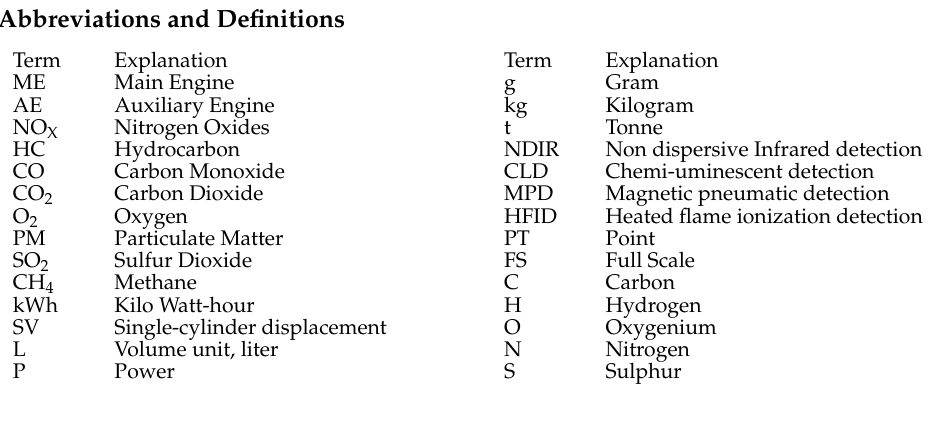
statistical results; Table S2: Fuel-based emission factors-CHINA I emission standard; Table S3: Fuel- based emission factors-CHINA II emission standard; Table S4: Energy-based emission factors-CHINA I emission standard; Table S5: Energy-based emission factors-CHINA II emission standard; Table S6: Carbon balance calculation method; Table S7: Marine diesel engine parameters under CHINA I emission standard (E3-cycle); Table S8: Marine diesel engine parameters under CHINA I emission standard (E2-cycle); Table S9: Marine diesel engine parameters under CHINA I emission standard (D2-cycle); Table S10: Marine diesel engine parameters under CHINA II emission standard (E3-cycle); Table S11: Marine diesel engine parameters under CHINA II emission standard (E2-cycle); Table S12: Marine diesel engine parameters under CHINA II emission standard